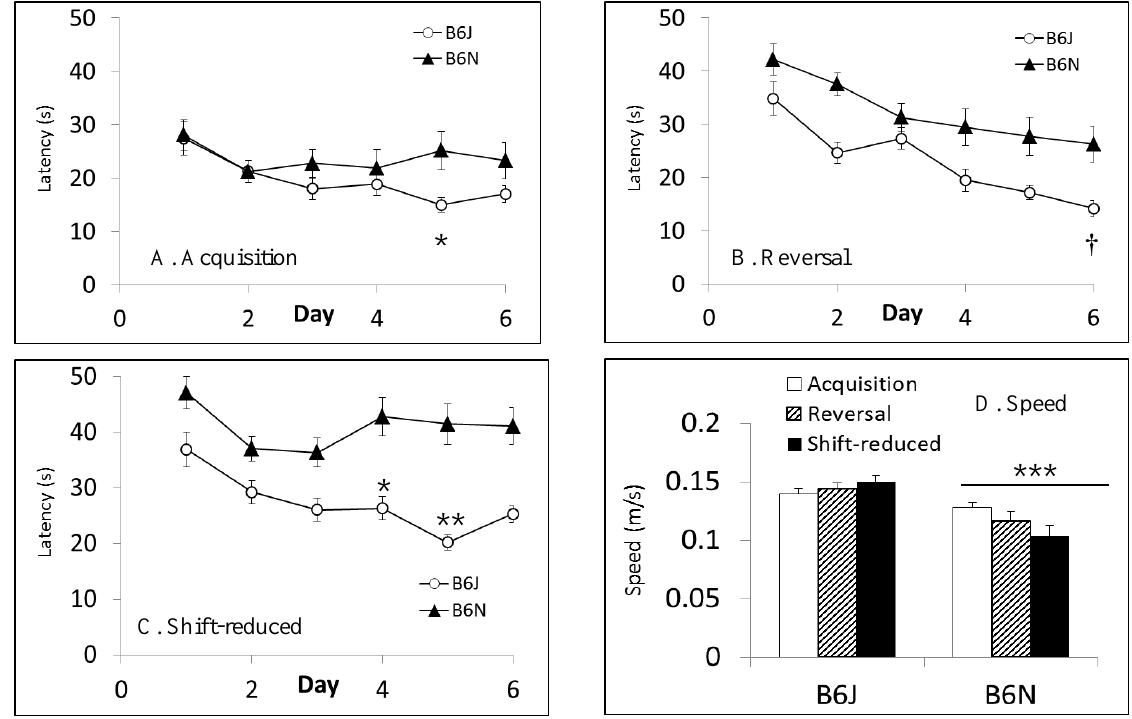
Figure 4. ( A – D ) Morris water maze latency: males. B6J males had shorter latencies to escaping. Swim speed was significantly different in all three phases of hidden platform